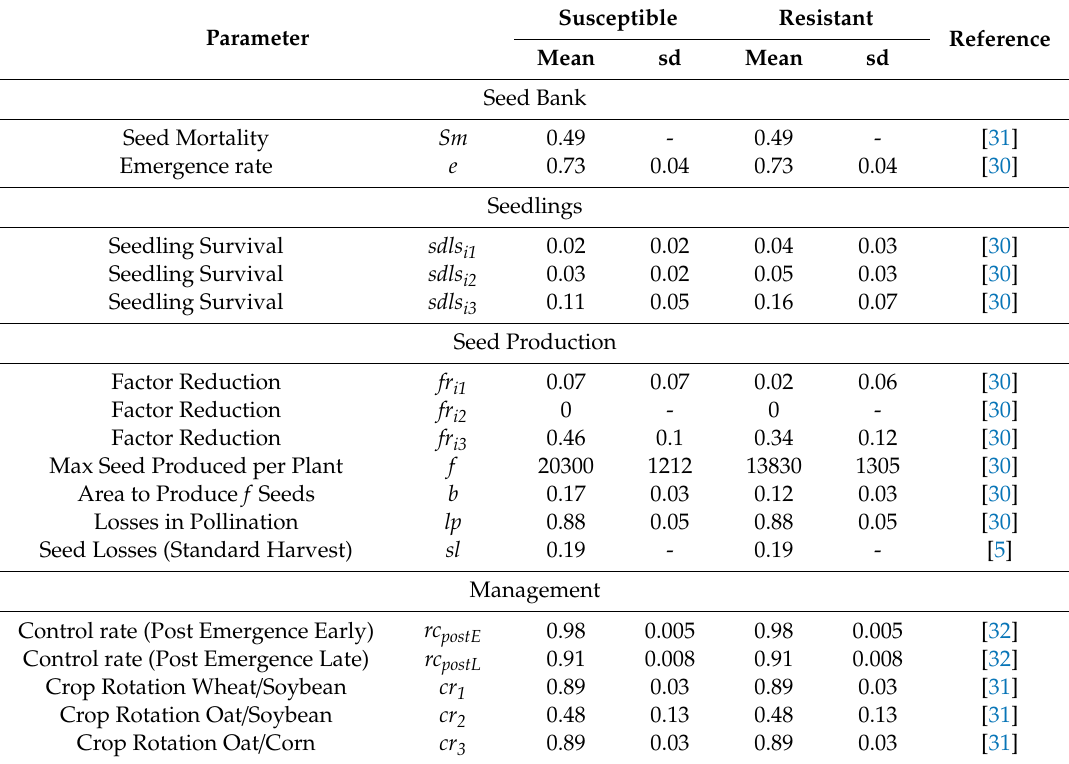
Table 1. Parameters used in the model. (sd: standard